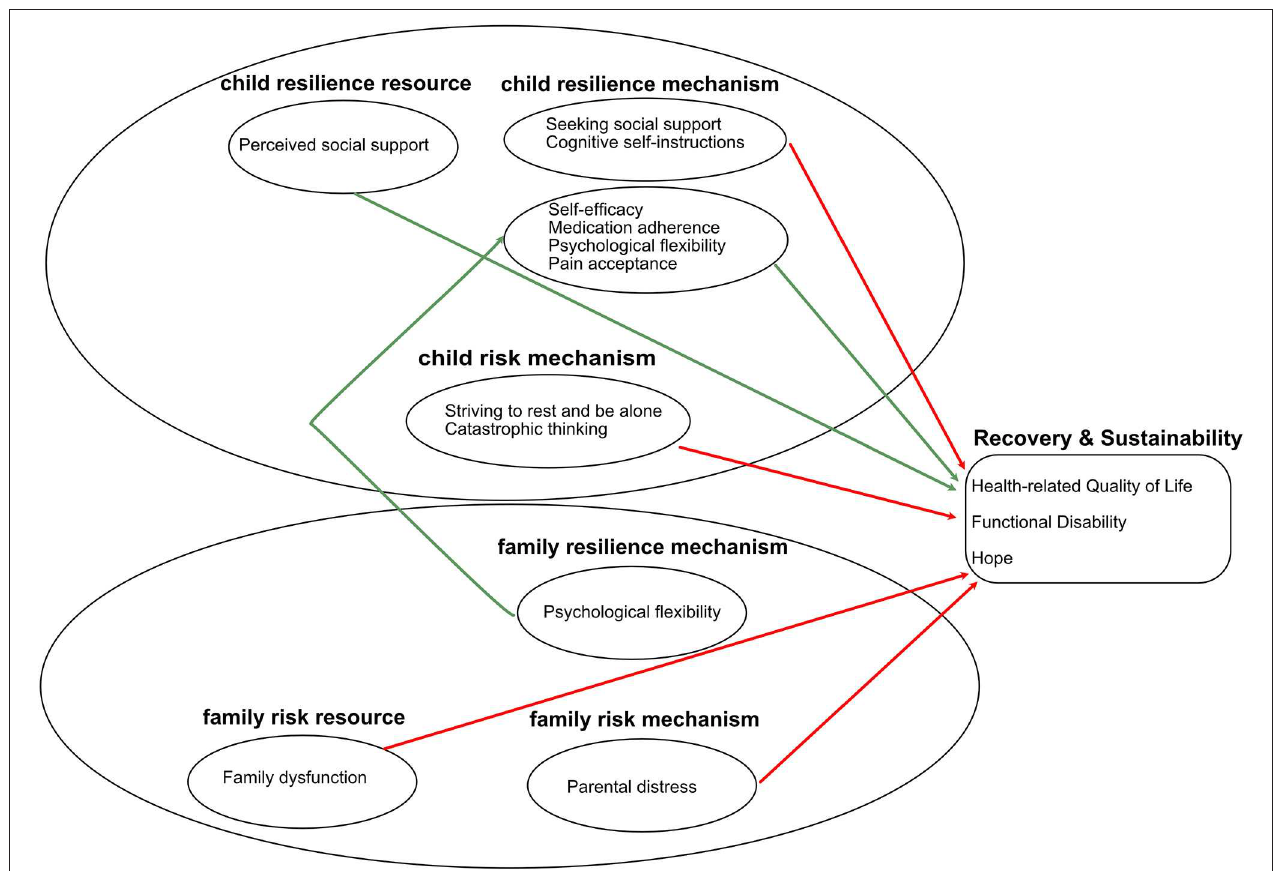
FIGURE 2 | Summary of the findings, using the Ecological Resilience-Risk Model as a framework. Red arrows represent negative associations, green arrows represent positive associations.